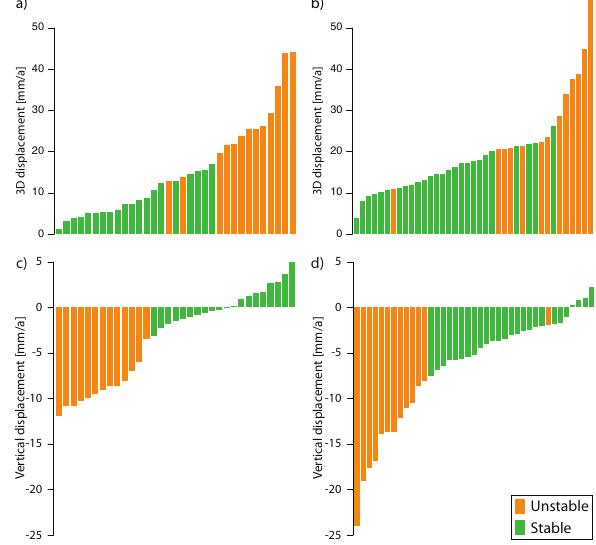
Figure 8. 3D length (a,b) and vertical component (c,d) of the displacement vectors derived from the laser scanning data (a,c) and the ATTS measurements